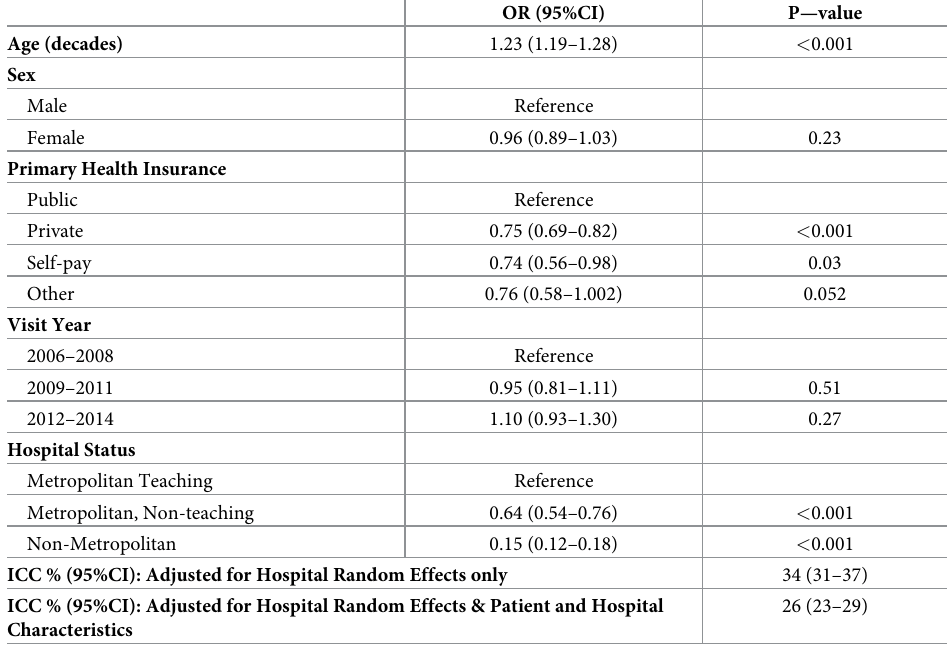
Table 2. Multilevel mixed effects model for cancer associated febrile neutropenia hospitalization Rates, 2006–